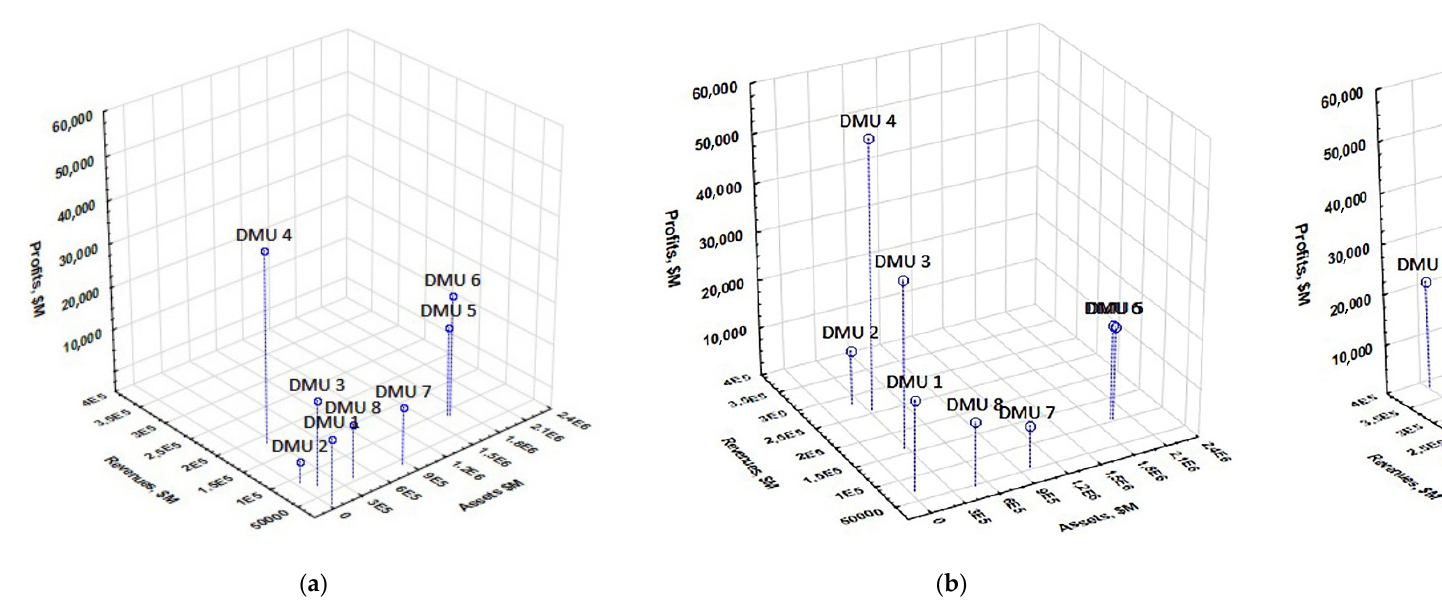
Figure 2. Dynamics of revenues, profits and assets indicators in three-dimensional coordinate space (USD millions). Source: calculated by the authors based on the data [59–83]. ( a ) 2015 (and beyond until 2019); ( b )—2020; ( с )—2021.